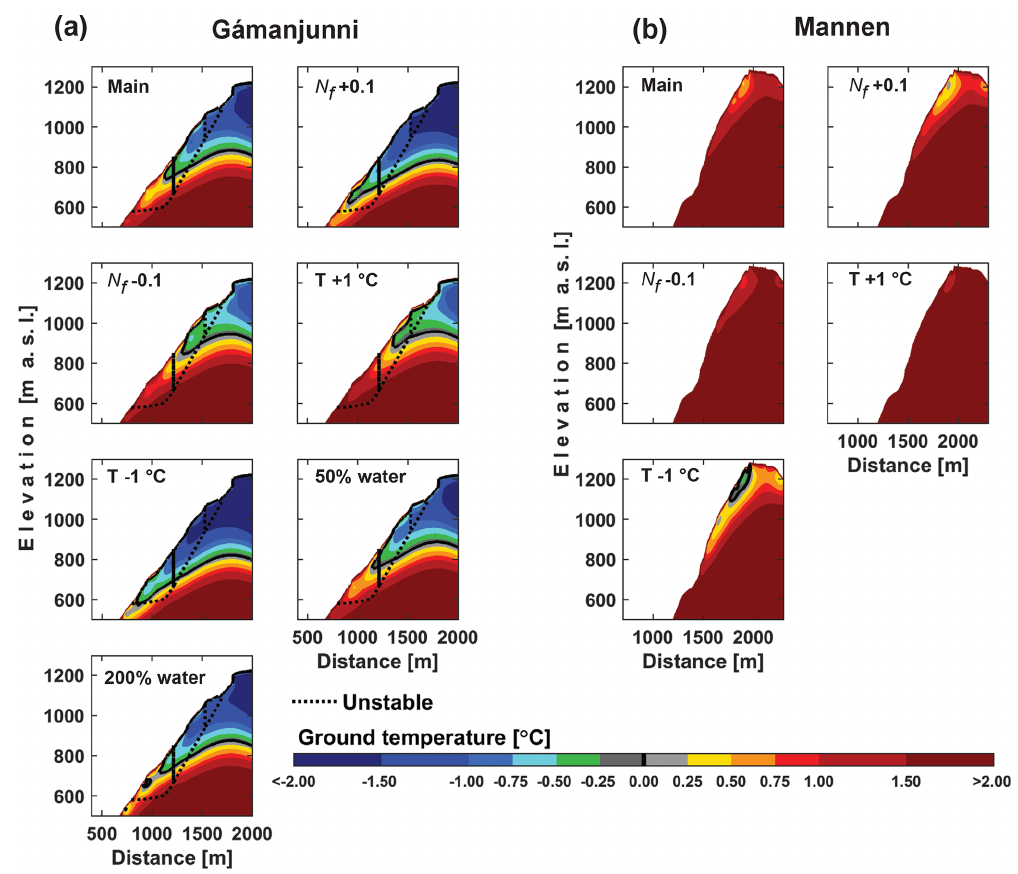
Figure A2. Sensitivity plots for the modelled ground thermal regime of (a) Gámanjunni-3 and (b) Mannen. The main run is the presented run in Fig. 7, and the panels show modelled ground temperature in response to changes in N f factor ( N f 0.1 means that N f is increased by 0.1; N f − 0 . 1 means that N f is decreased by 0.1), forcing SAT (T1 ◦ C means that SAT is increased by 1 ◦ C; T–1 ◦ C means that SAT is decreased by 1 ◦ C) and water content in the subsurface (50% water means that water content is halved and the remaining fraction is added to the mineral fraction; 200% water means that water content is doubled by reducing the mineral fraction). GT and permafrost geometry change in response to these variations. It is noteworthy at Mannen that only small changes in snow or forcing temperatures would produce considerably more permafrost in the unstable area. Due to limited assumed sediment cover for the Mannen site, we did no sensitivity plot for the water content in bedrock, which is